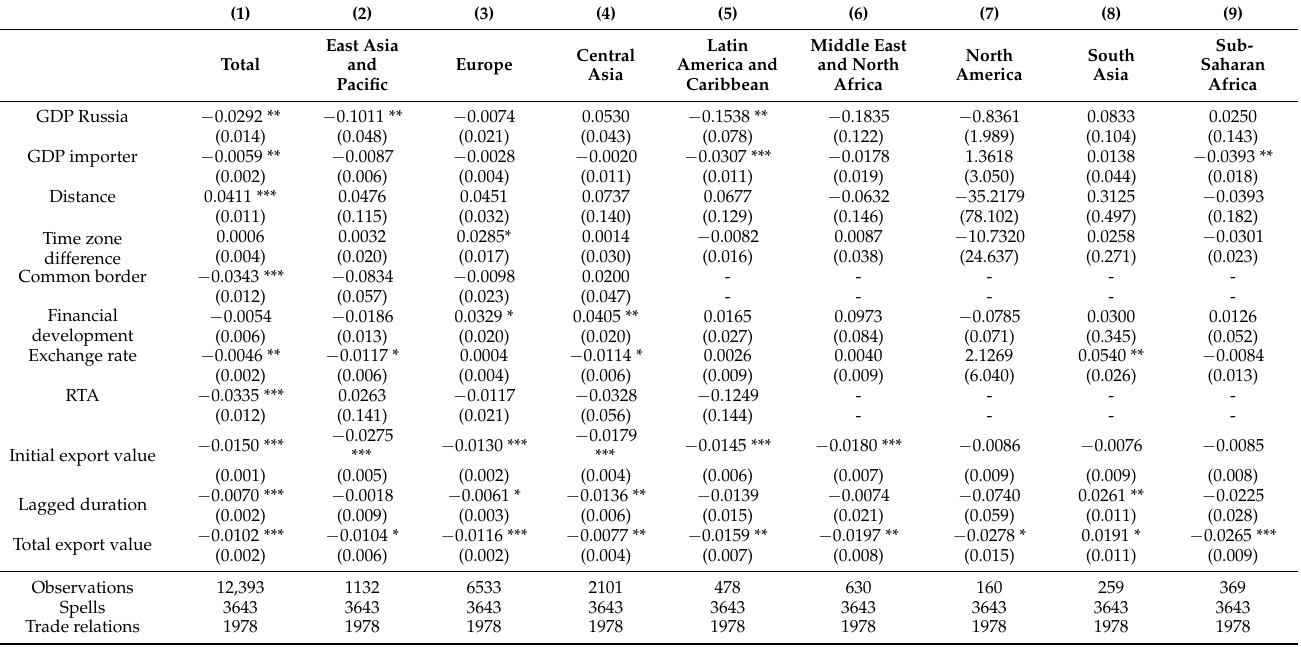
Table 2. Logit regression marginal